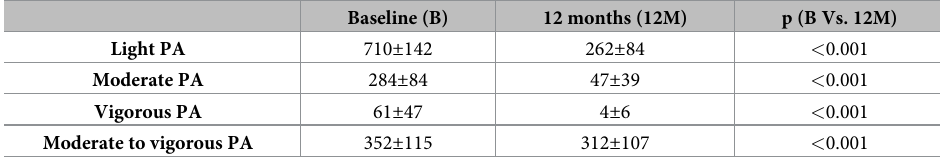
Table 2. PA (minutes/day) at baseline and after 12 months of intervention (Mean ± SD). Baseline (B)